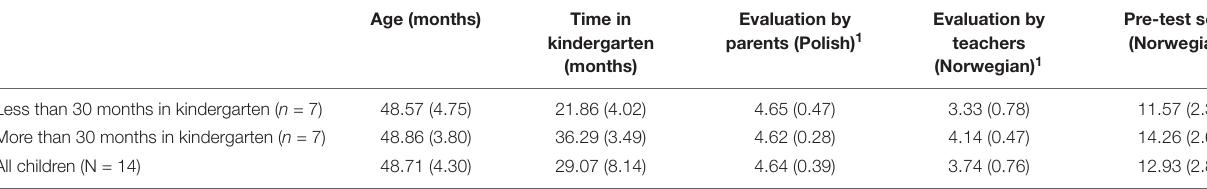
TABLE 2 | Indicators of the participating children’s skills in Polish and Norwegian (means and standard deviations).